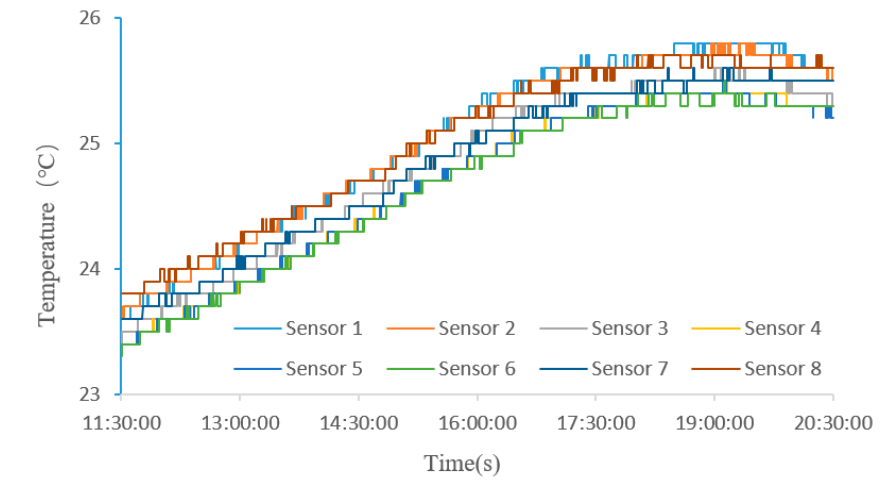
Figure 6. The temperature changes at the measurement locations on the left column.